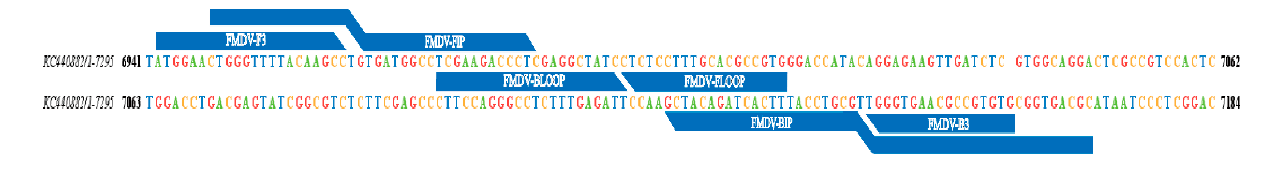
Figure 2. Target region of the visual RT ‐ LAMP primers for pan ‐ serotypic FMDV detection is shown, and reference sequence is KC440882 for FMDV type A isolate EGY 1/2012.